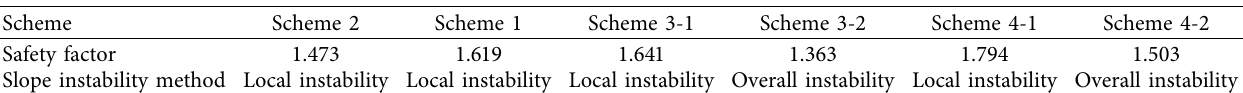
Figure 15: Plastic zone (a, c, d) and landslide form (b, e) of critical instability in the landfill slope under different schemes. (a) The plastic zone of critical buckling destruction in the waste pile slope (Scheme 1; safety factor is 1.473). (b) The landslide form of critical buckling destruction in the waste pile slope (the deformation scale factor is 15). (c) The plastic zone of critical buckling destruction in the waste pile slope (Scheme 3-1; the safety factor is 1.641). (d) The plastic zone of critical buckling destruction in the waste pile slope (Scheme 3–2; the safety factor is 1.363). (e) The landslide form of critical buckling destruction in the waste pile slope (the deformation scale factor is Table 7: Slope safety factor of critical instability in 4 schemes.